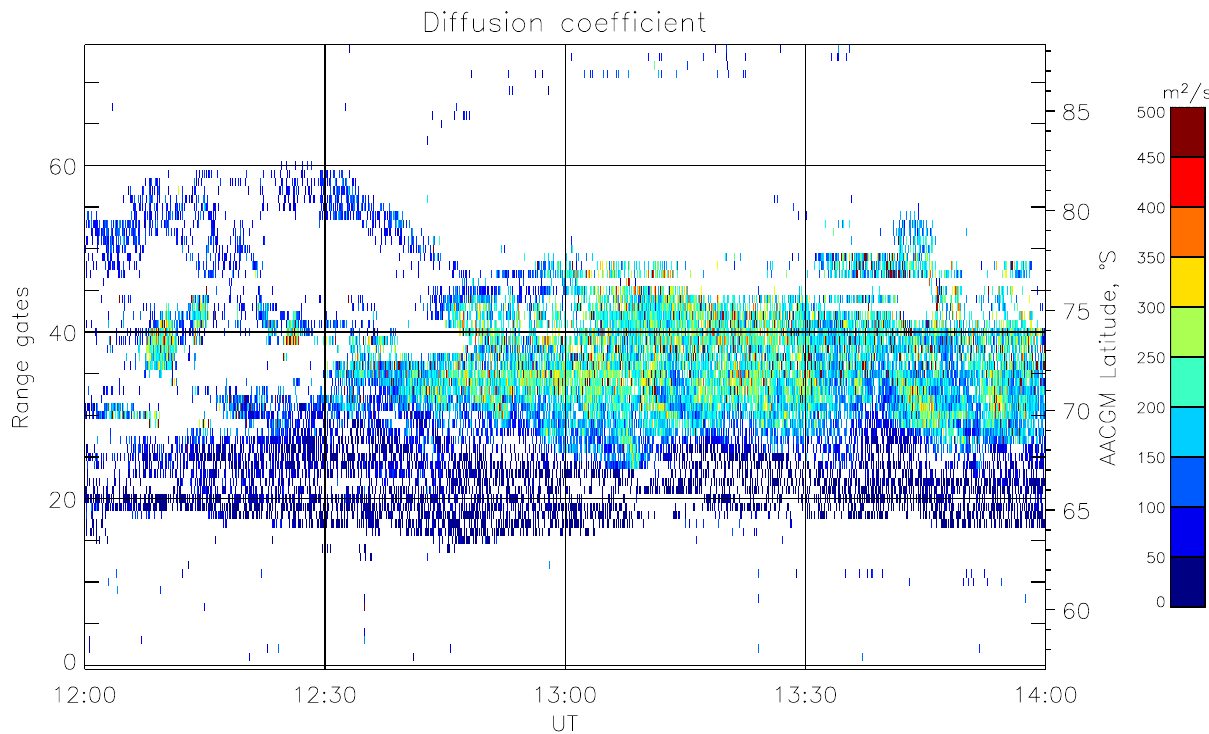
Fig. 15. Effective diffusion coefficient estimated by fitting Eq. (2) to the experimental ACF power (ionospheric